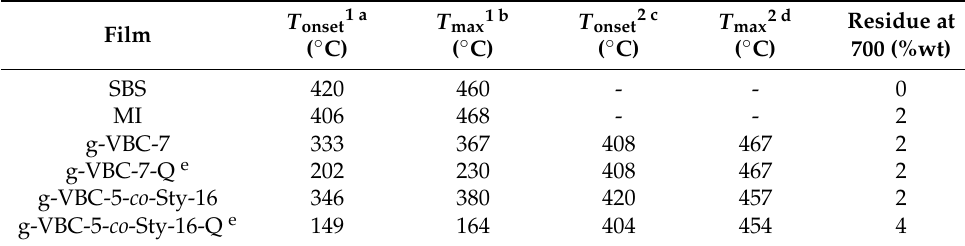
Table 3. DSC data of SBS, MI, and graft copolymers.